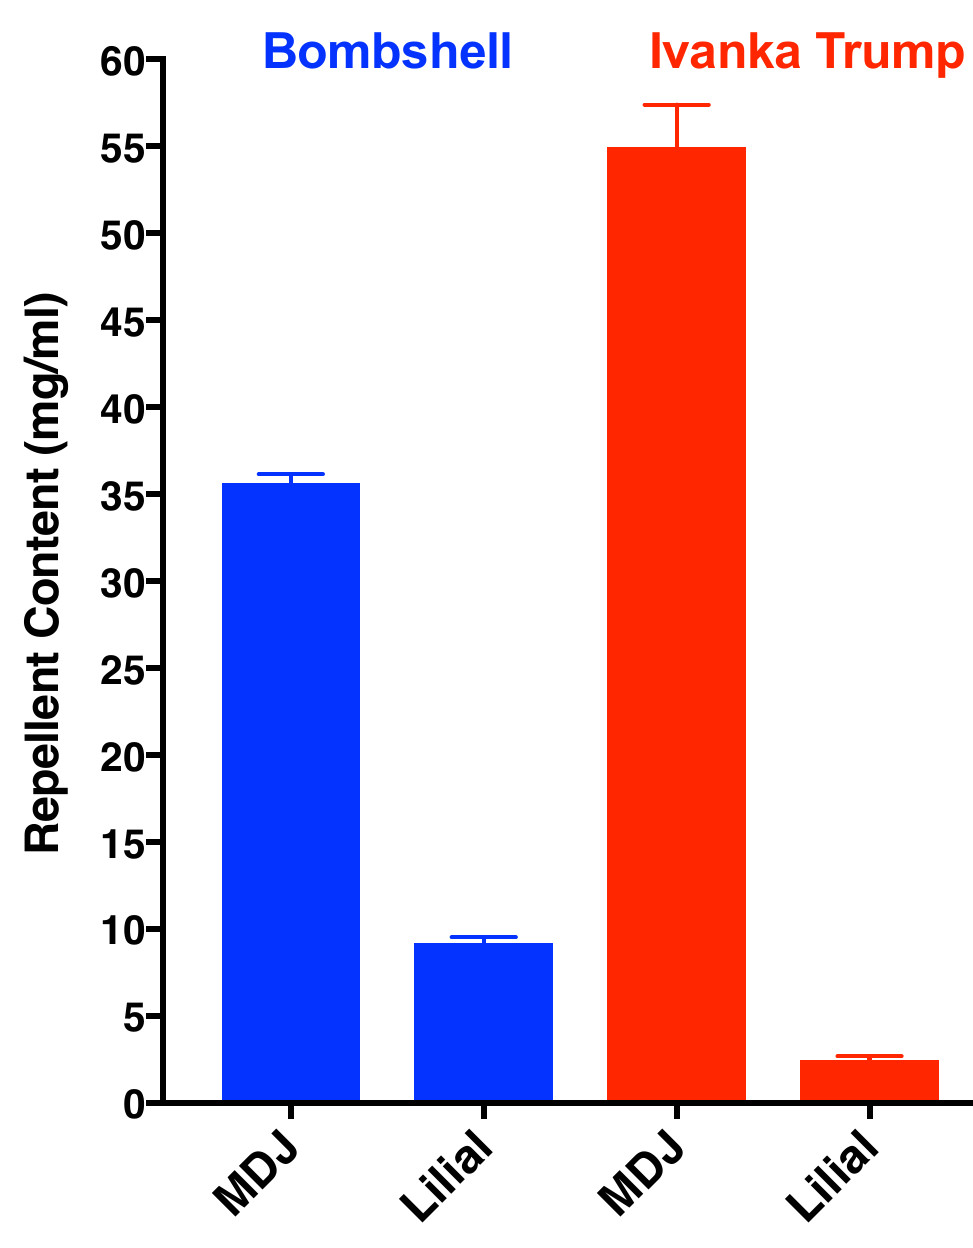
Fig 5. Concentrations of MDJ and lilial in Bombshell (left, blue) and Ivanka Trump (right, red) eaux de parfums. Amounts were estimated by gas chromatography after calibrating the responses of the flame ionization detector with standards. Perfumes were diluted 1,000x for injections (n = 3). The data are expressed as mean ± SEM.